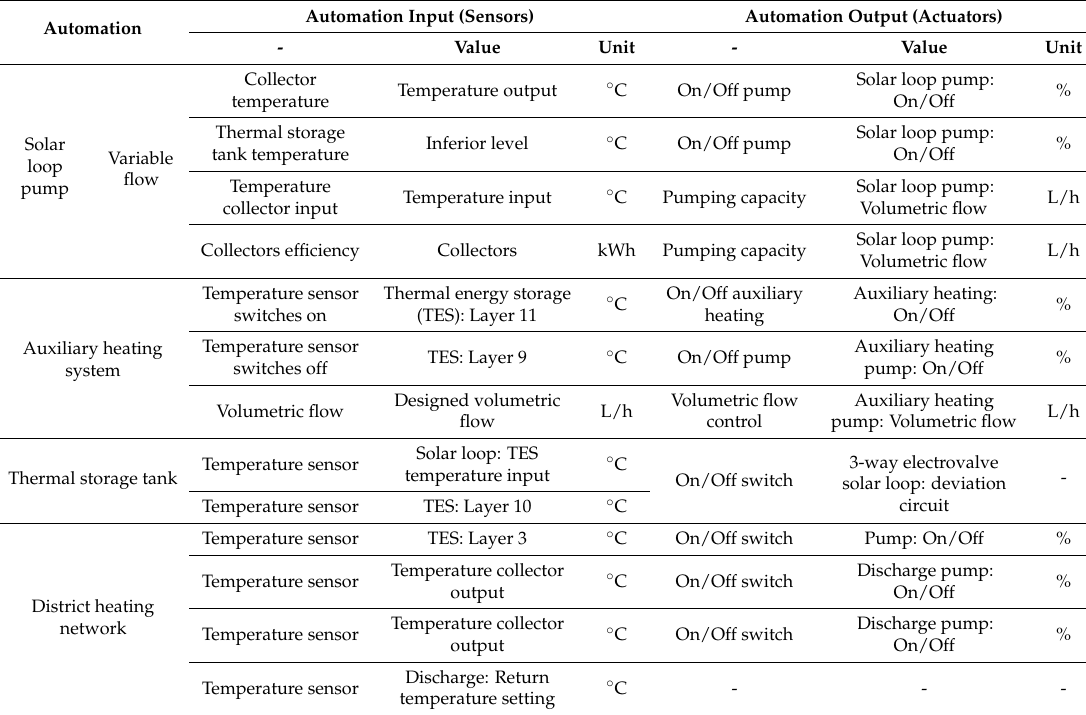
Table 7. The control algorithm attached to the hybrid heating system.